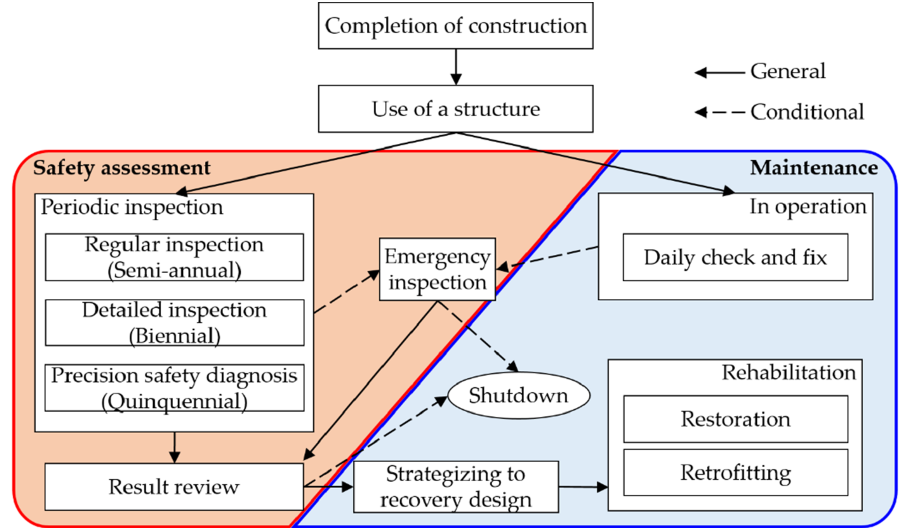
Figure 1. Flowchart of the conventional safety assessment and maintenance processes.